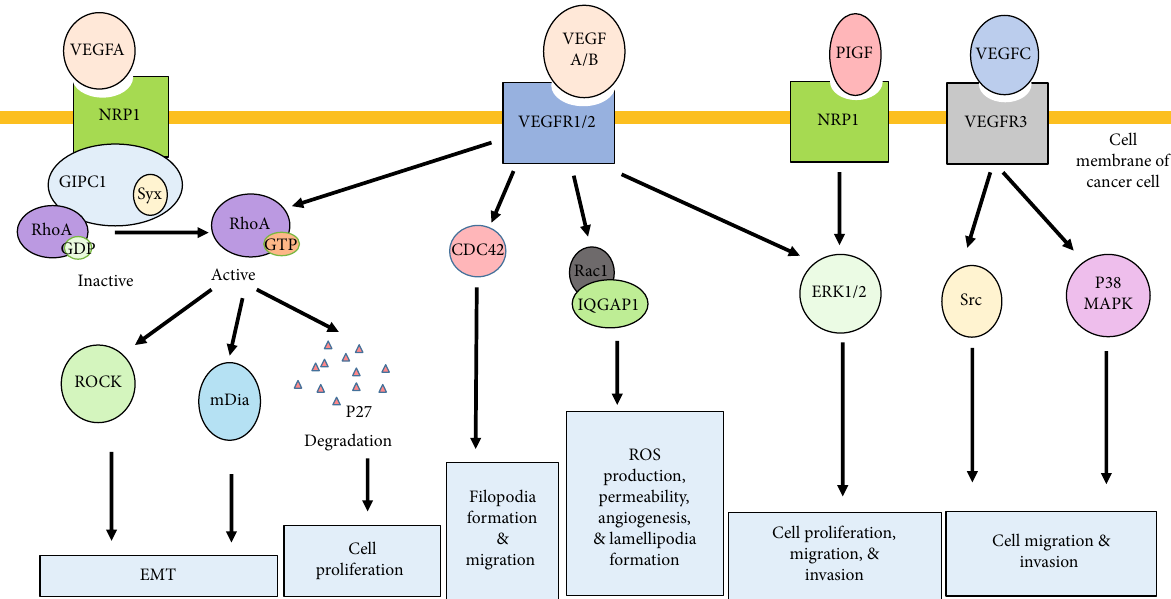
Figure 3: Regulation of cancer hallmarks by the crosstalk between VEGF and Rho GTPase signaling pathways. The formation of cytoplasmic structures, cell migration, invasion, EMT, ROS production, and cell proliferation can be modulated by binding of VEGFA, VEGFB, or VEGFC to their corresponding VEGFR or NRP receptors. VEGFC interacts with Rho GTPases to upregulate Src and p38 MAP kinase activity. VEGFA and VEGFB modulation of cancer hallmarks involves the activation of Rho GTPases and their downstream e ff ectors (ROCK, mDia, and p27) as well as the MAPK